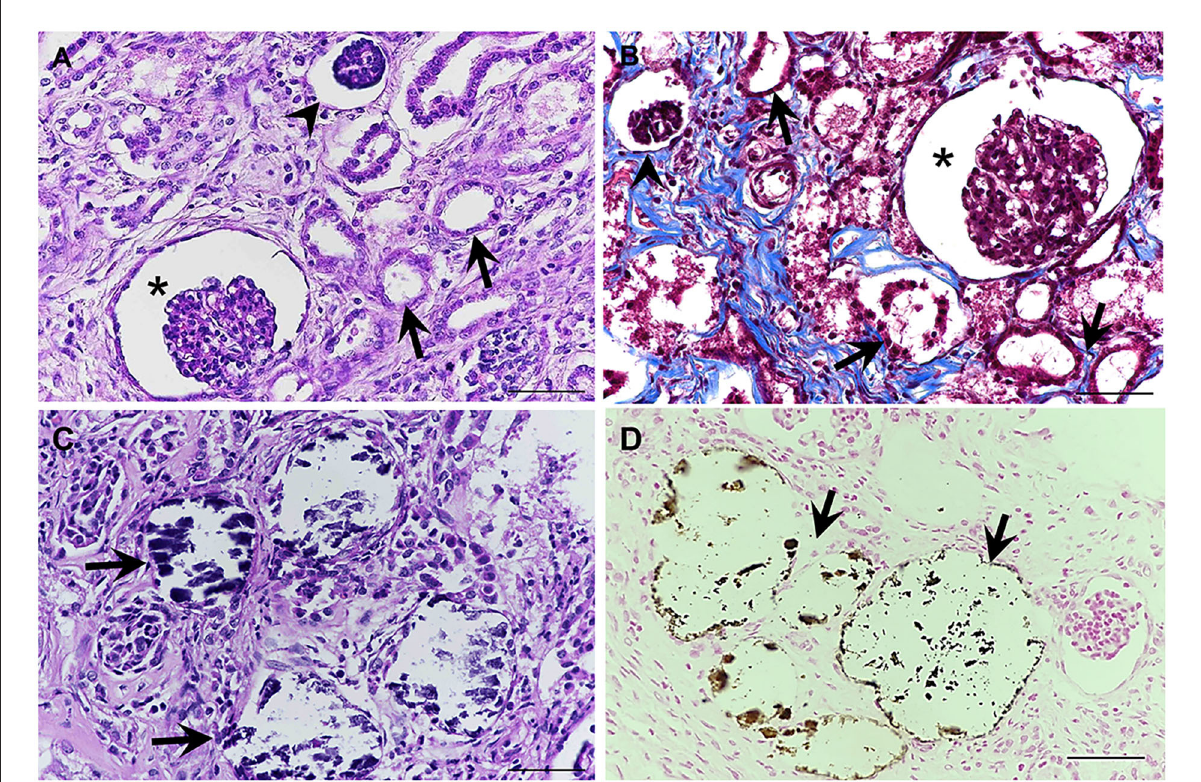
FIGURE3 (A,B) The interstitial fibrosis surrounding the segmental nephrons and associated with the dilation of tubules (arrows), dilatation of Bowman’s space (asterisks), and atrophic glomerulus (arrowheads) was frequently noted in the corticomedullary junction of the kidney (A) (H&E stain). Masson’s trichrome stain was performed to confirm the presence of fibrotic tissue, which presented a positive blue color (B) . (C,D) Localized mineralization (arrows) in the lumen of the renal tubules was observed (H&E staining) (C) , which is confirmed by Von Kossa stain (D) (Mayer’s Hematoxylin counterstained, scale bar = 50 µ